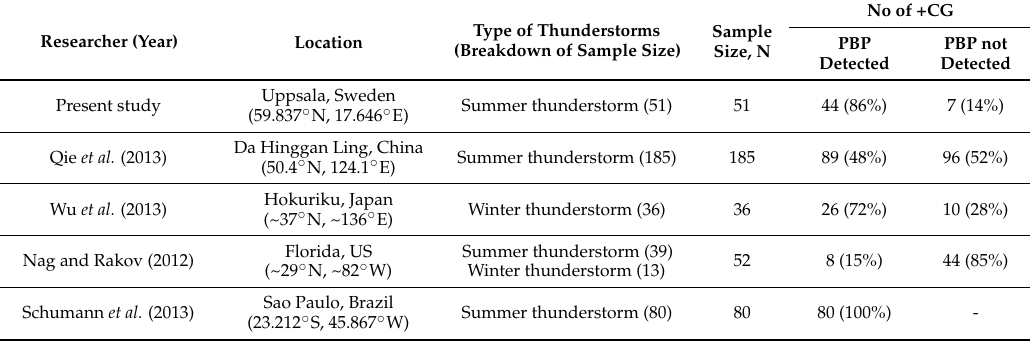
Table 1. Percentage of positive ground flashes (+CG) with detectable preliminary breakdown pulses